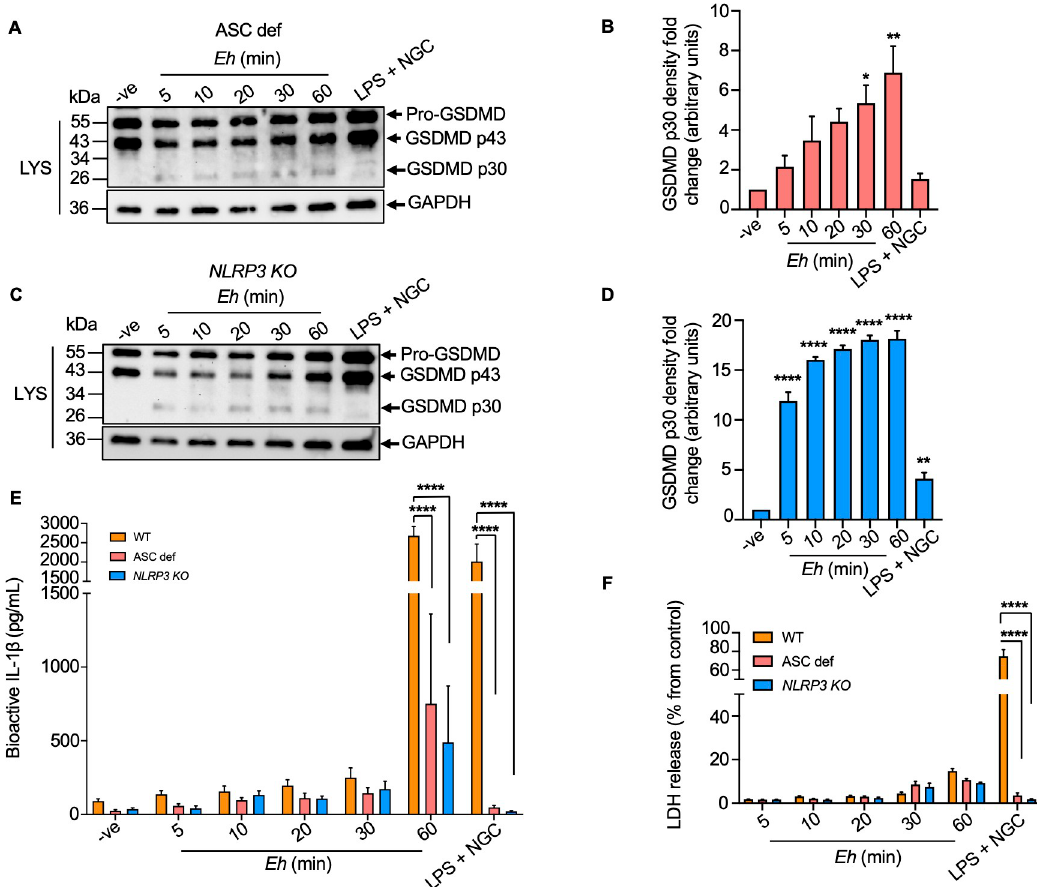
Fig 8. E . histolytica -induced gasdermin D cleavage is not dependent on the canonical NLRP3 inflammasome components. ( A, C ) ASC def and CRISPR/Cas9 NLRP3 KO macrophages were incubated with Eh from 5 min to 60 min or the positive control, LPS (50 ng/mL) and NGC (10 μ M) for 60 min. Equal amount of cell lysates (LYS) was loaded onto SDS-PAGE and immunoblot analysis was performed for GSDMD p30 pore-forming fragment presented in lysates and blots were reprobed with GAPDH. ( B, D ) Quantification of cleaved GSDMD p30 fragment was performed by densitometric analysis from three independent experiments, and the negative (cells only) acted as an internal control. ( E ) Bioactive IL-1 β levels were quantified by SEAP assay that detected in HEK-Blue reporter cells. ( F ) Cell death was quantified by LDH release into the culture supernatant and is shown as a percentage of LDH release compared to non-stimulated cells (control). ( E, F ) Statistical significance was calculated between WT and ASC def, WT and NLRP3 KO as well as between ASC def and NLRP3 KO macrophages at each time point. Data and immunoblots are representative of at least three independent experiments (n = 3) and statistical significance was calculated with ANOVA and Bonferroni’s post-hoc test ( � p < 0.05, �� p < 0.01, ���� p < 0.0001). Bars represent mean ± SEM.